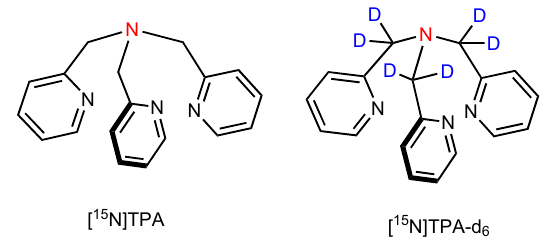
Fig. 1 Structure of 15 N-labeled tris(2-pyridylmethyl)amine derivatives discussed in this work. Tripodal ligands based on tris(2-pyridylmethyl) amine form Zn 2 + complexes with high stability and excellent